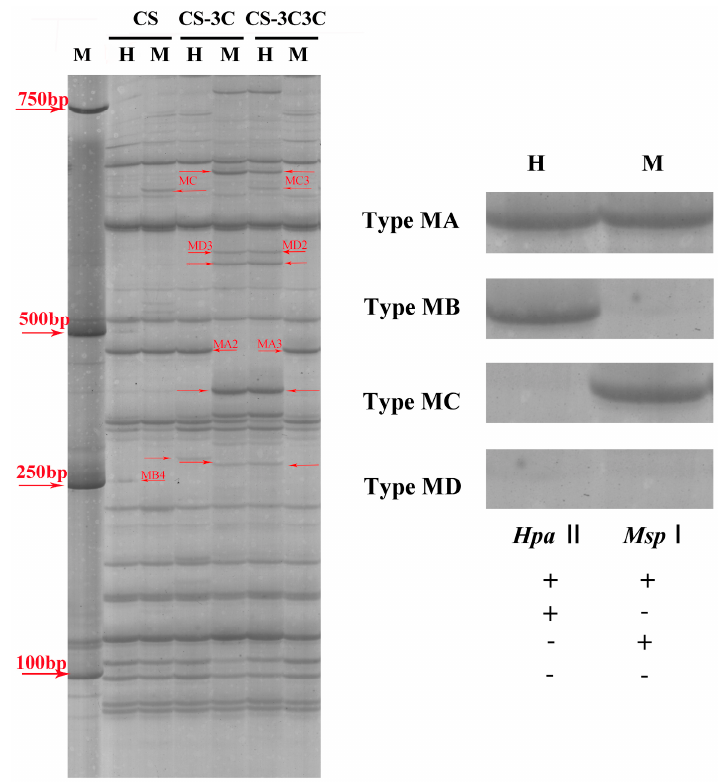
Figure 1. Representative variation of DNA methylation pattern. H ( Eco R I + Hpa II digest) and M ( Eco R I + Msp I digest) refer to digestion with Eco R I + Hpa II and Eco R I + Msp I, respectively. “ → ” red arrows represent parts of differential methylated bands between common wheat and wheat carrying Gc chromosome(s). M stands for Marker DL2000. MA (1, 1), presence in both H ( Eco R I + Hpa II digest) and M ( Eco R I + Msp I digest) lanes; MB (1, 0), presence in H and absence in M lane; MC (0, 1), absence in H but presence in M lane; MD (0, 0) absence in both H and M lanes. CS: T. aestivum cv. Chinese Spring. CS–3C: monosomic addition line of Chinese Spring (CS) that carries a gametocidal chromosome 3C originated from Aegilops triuncialis . CS–3C3C: disomic addition line of Chinese Spring (CS) that carries two gametocidal chromosome 3C originated from Aegilops triuncialis .